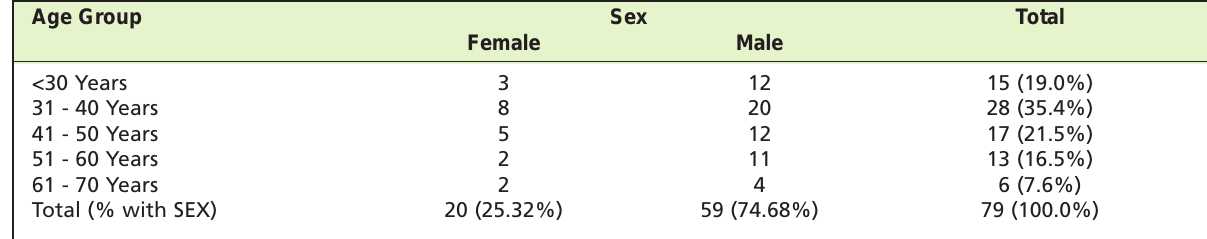
Distribution of the study group according to age and sex Table I: